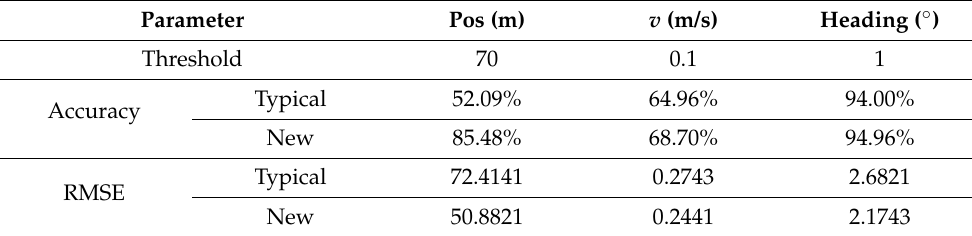
Table 3. Accuracy and RMSE comparison